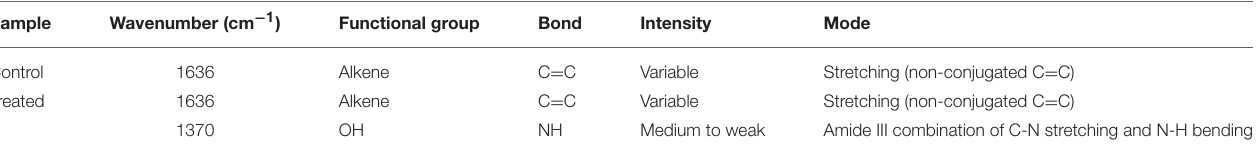
TABLE 1 | FTIR spectrum of Brevibacterium sp. SOTI06.